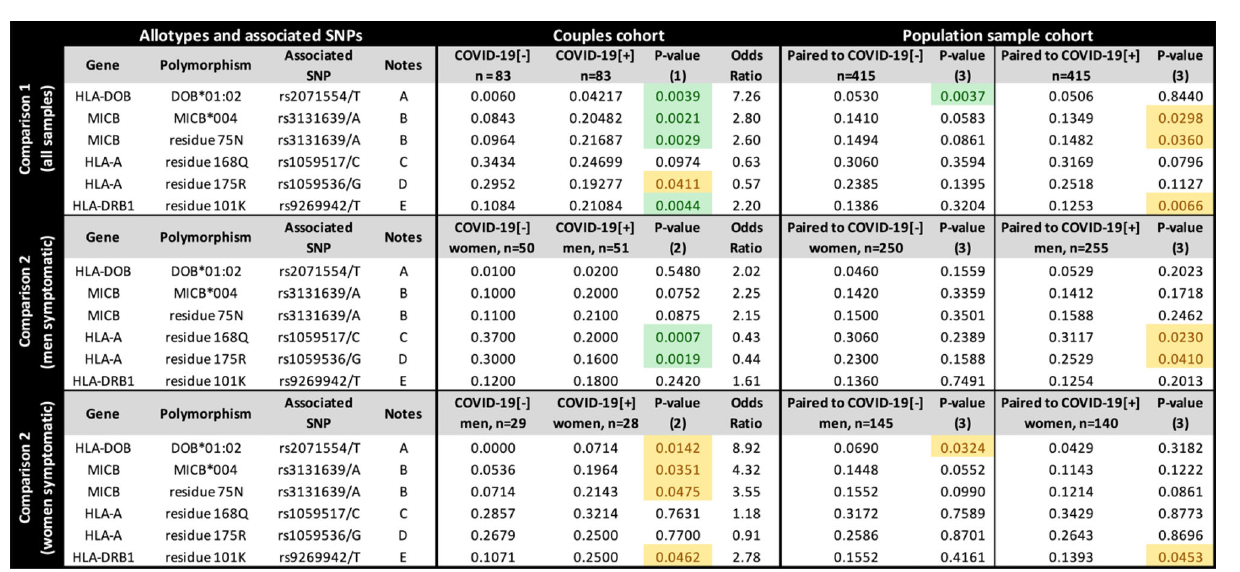
FIGURE 3 | The frequency of each candidate allotype and amino acid residue encoded in the Major Histocompatibility Complex (MHC) associated with susceptibility to SARS-CoV-2 symptomatic infection or with asymptomatic and seronegative after exposure. COVID-19[+]: Patients with symptomatic COVID-19. COVID-19[-]: Individuals sharing the same bed with symptomatic patients (exposed individuals) and are asymptomatic and seronegative. P-value (1): Logistic regression comparing all COVID-19[+] and all COVID-19[-] individuals, controlling for sex, age, and genetic ancestry; P-value (2): Logistic regression comparing COVID-19[+] and COVID-19 [-] individuals, controlling for age, and genetic ancestry; P-value (3): Fisher exact test, comparing COVID-19[+] or COVID-19[-] individuals with a population sample paired by gender and genetic ancestry. In green, P-values < 0.005; In yellow, P-value between 0.005 and 0.05. Notes: (A) DOB*01:02 is the only HLA-DOB allotype carrying residue 18Q; (B) MICB*004, *024, *028 carry residue 75N (residue 75 in the full-length protein); (C) This residue is common to many HLA-A alleles, including A*23:01, A*25:01, A*26:01, *29:02, *30:01, *30:02, *31:01, *32:01, *33:01; (D) This residue is common to many HLA-A allotypes, including A*23:01, *29:02, *30:01, *30:02, *31:01, *32:01, *33:01; (E) This residue occurs in DRB1*03:01, *03:02, *04:01,*04:09, *13:03. rs9269942/T captures only a fraction of the sequences encoding K at position 101 from HLA-DRB1, since the composition of other surrounding variants, including indels, can produce the codon for